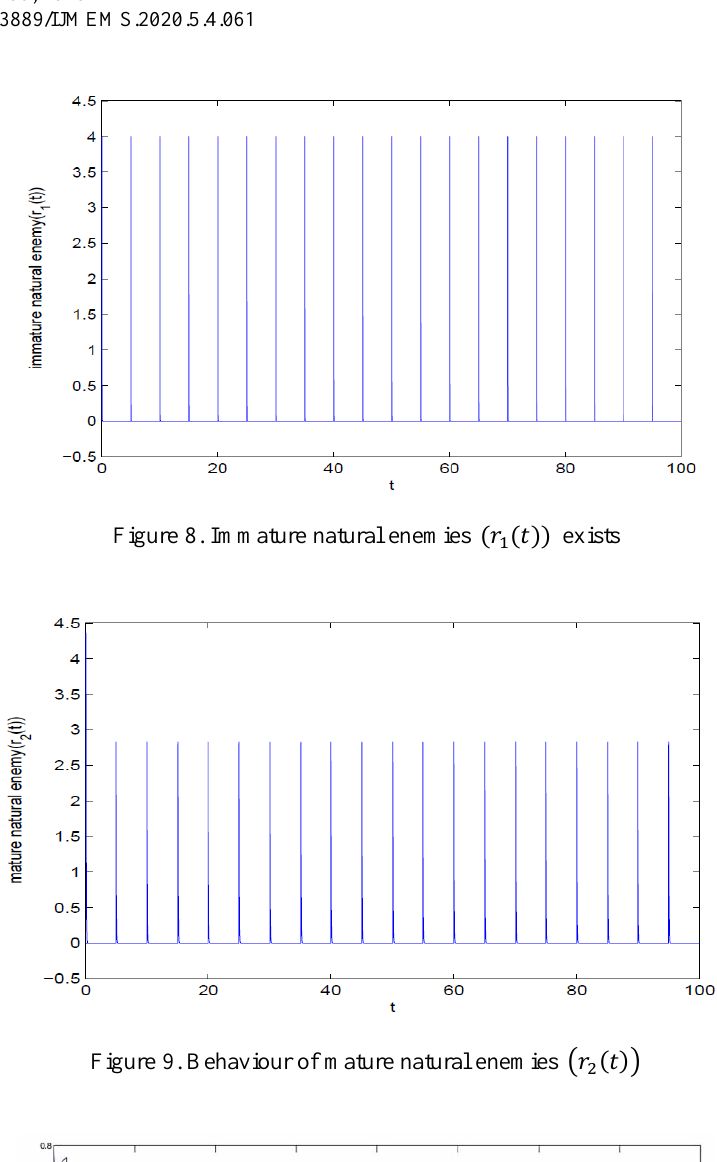
Figure 9. Behaviour of mature natural enemies (𝑟